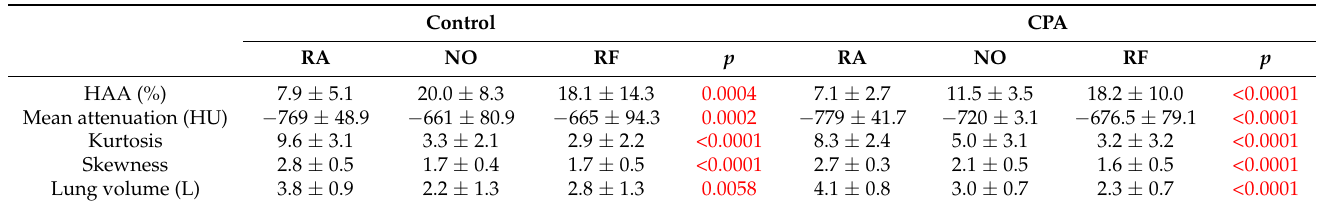
Table 5. Correlation between for oxygen demand and quantitative parenchyma analysis profiles.